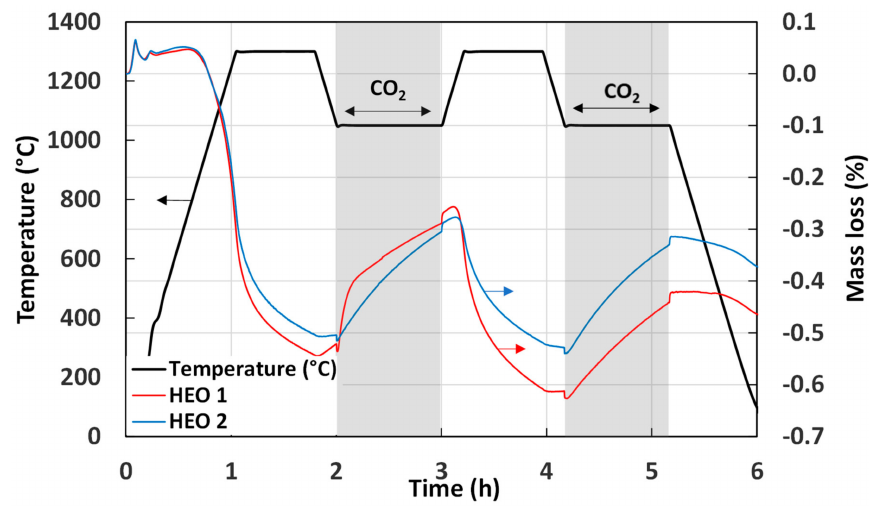
Figure 4. Thermogravimetric analysis of two consecutive CO 2 -splitting cycles with HEO 1 and HEO 2.